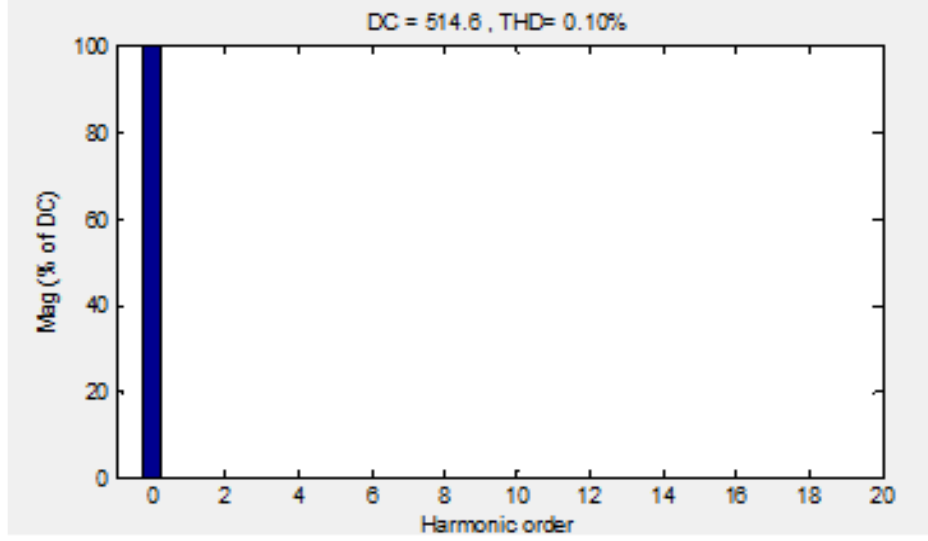
Figure 8. DC bus voltage control harmonics spectrum.